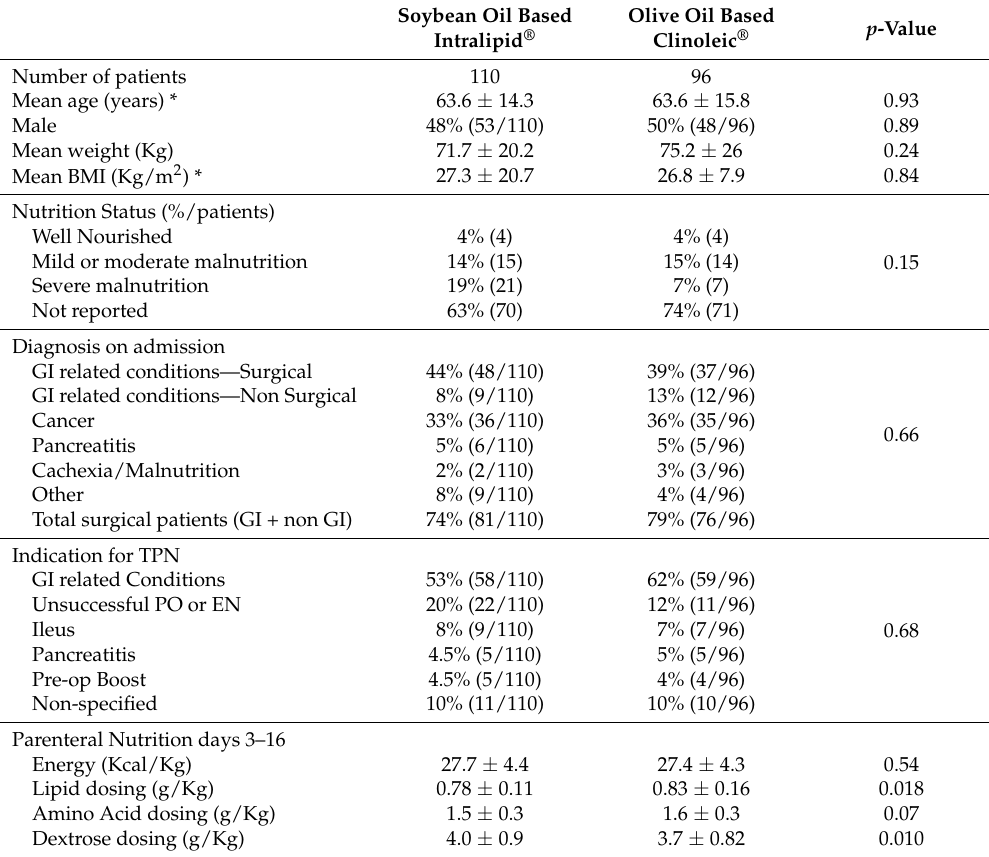
Table 2. Characteristics of